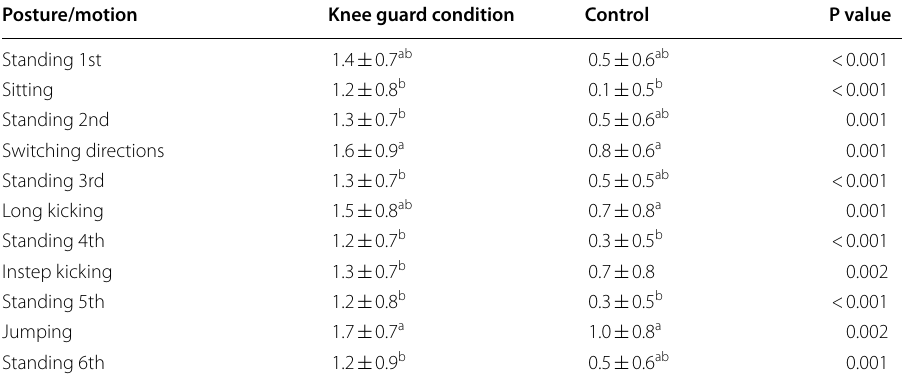
Table 3 Skin pressure distribution by measured points and posture with and without knee‑